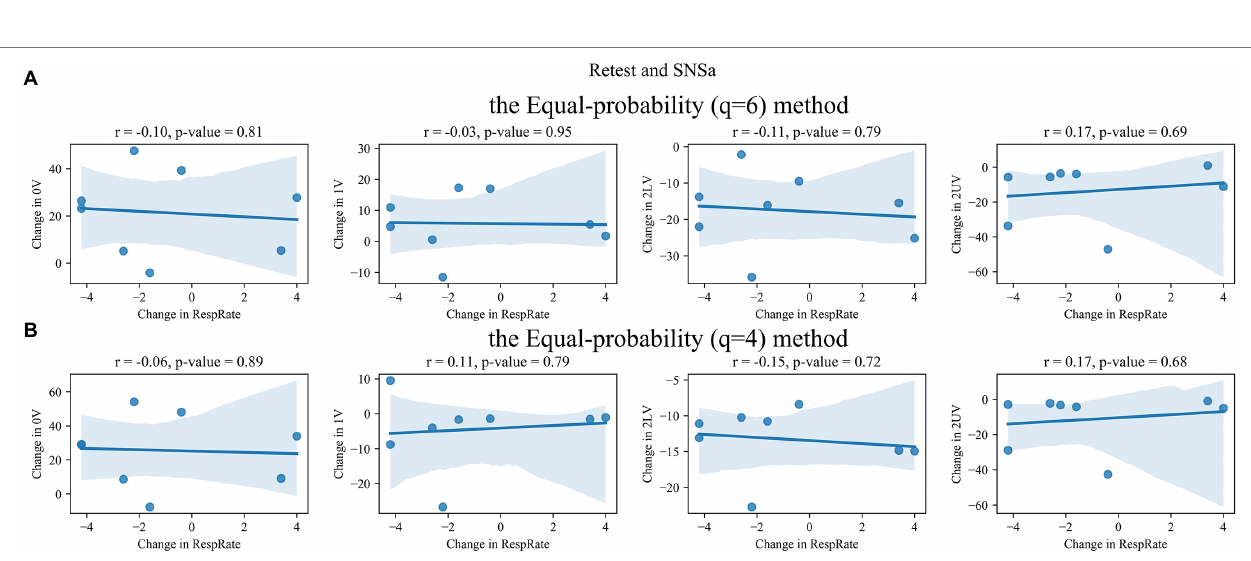
FIGURE 9 | Correlation between SNSa stimulation–retest differences in SymDyn indices and differences in respiratory rate (RespRate): the Equal-probability method (A) q = 6, (B) q = 4.